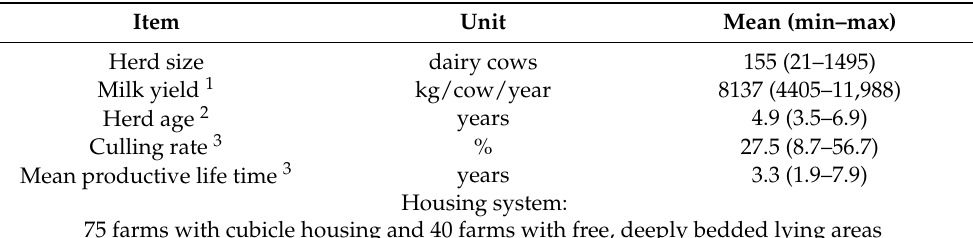
Table 1. Selected key data of the 115 project farms in 2014, mean values and range (min–max) at herd